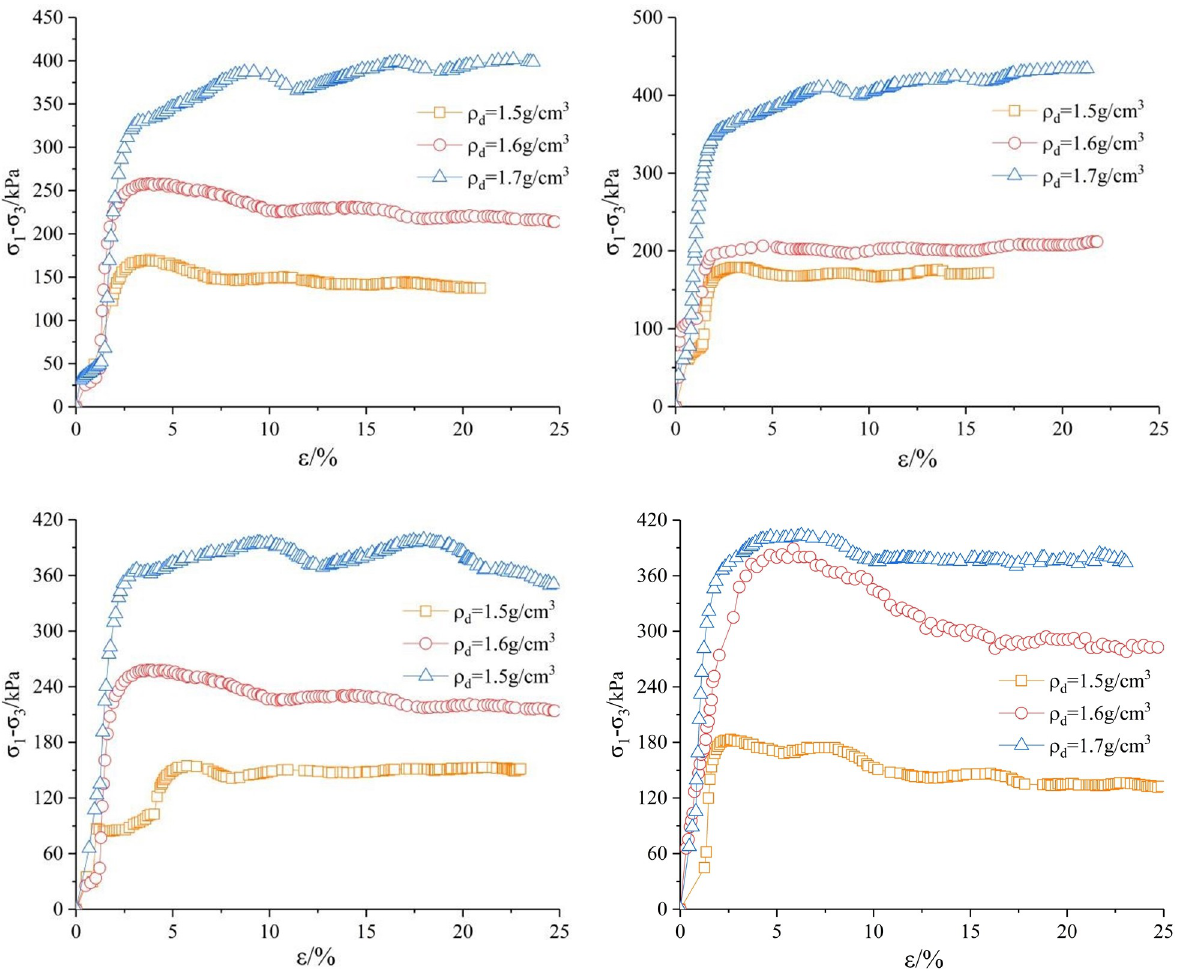
Fig 5. σ 1 -σ 3 ~ ε curve under confining pressure of 200 kPa . (a) Shear rate v = 0.04 mm/min . (b) Shear rate v = 0.08 mm/min . (c) Shear rate v = 0.16 mm/min . (d) Shear rate v = 0.4 mm/min .